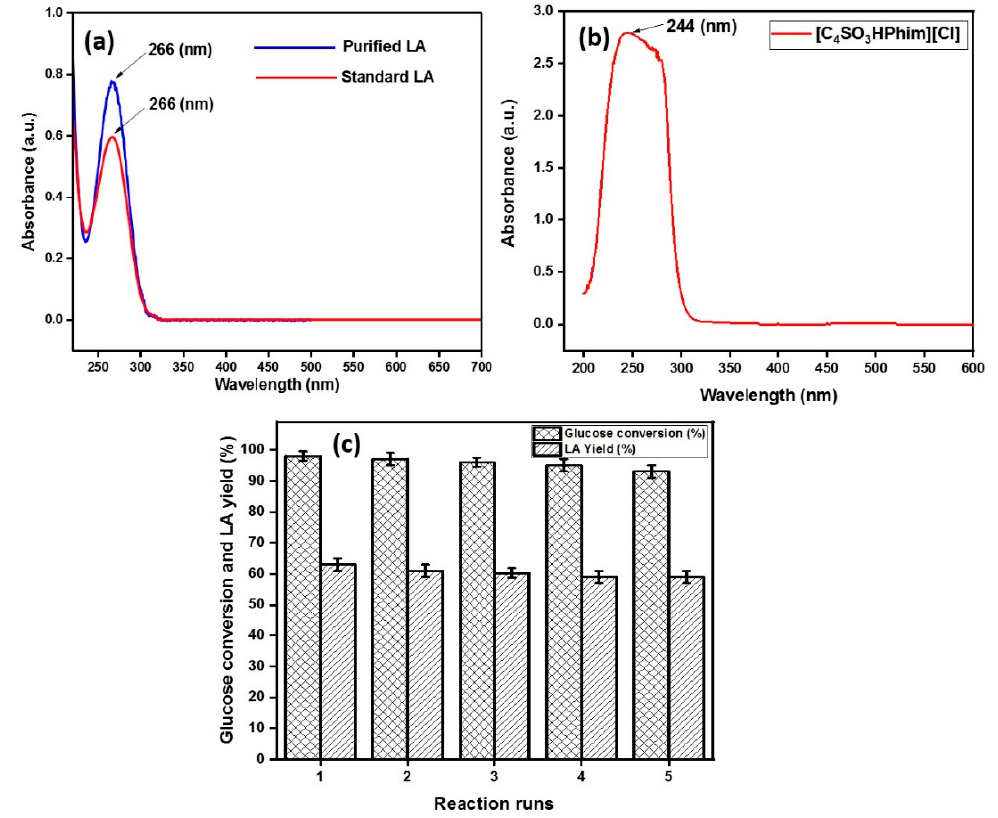
Figure 6. UV–vis spectrum of purified LA and standard LA ( a ) UV–vis spectrum of the IL catalyst [C 4 SO 3 HPhim][Cl] ( b ) Reusability of the IL catalyst [C 4 SO 3 HPhim][Cl] ( c ).